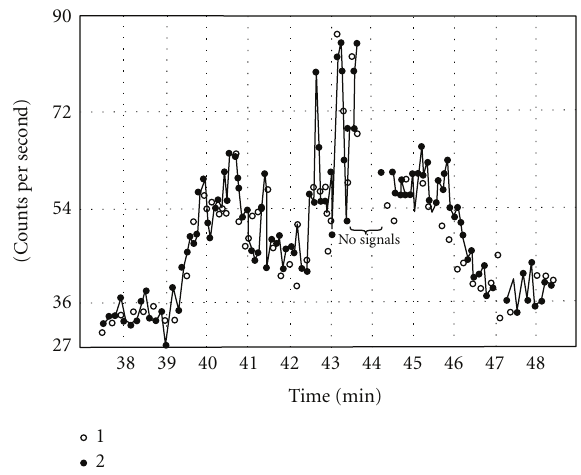
Figure 3: Variations of cosmic ray intensity along one of the orbits of the second satellite over the northern regions of the USSR. Nowadays it is clear that they were due to the precipitation of the particles from the outer radiation belt during geomagnetic activity. Numbers 1 and 2 correspond to the read-outs of the two